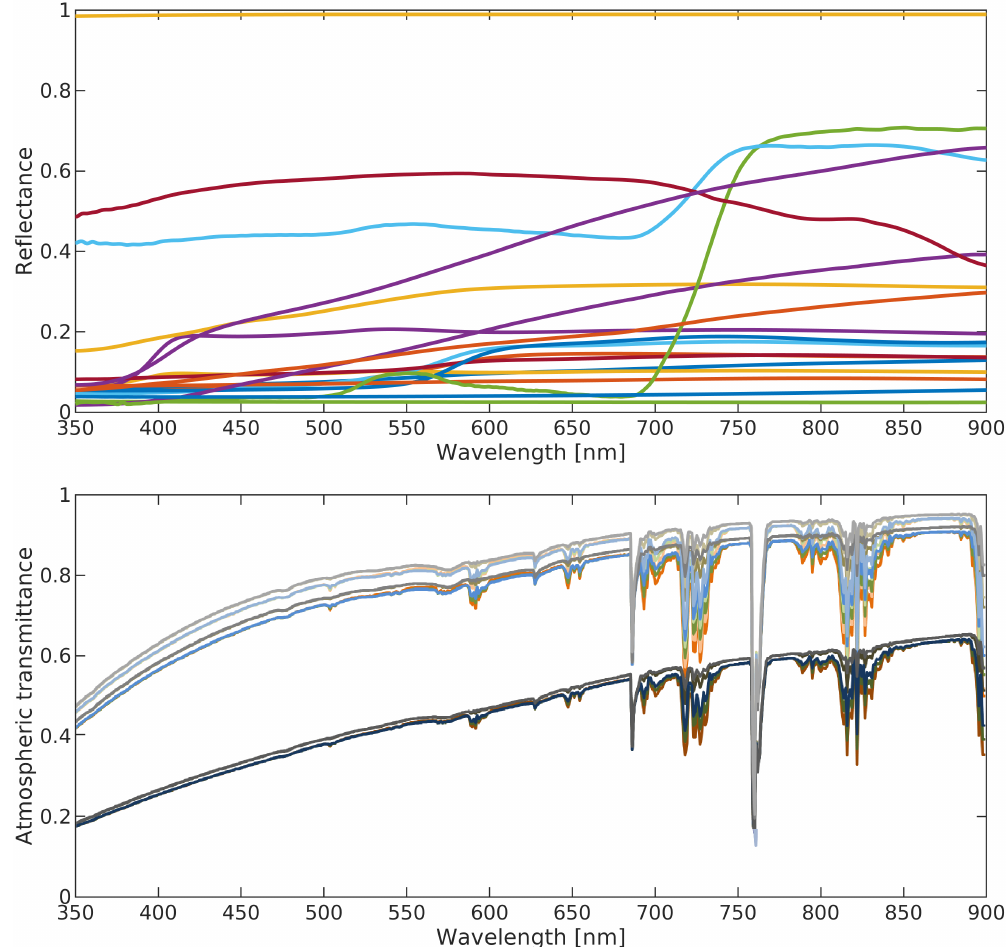
Figure 3. Top : Variation in surface reflectances for selected 18 spectra; bottom : Variation in atmospheric transmission curves for selected five atmospheric profiles and visibilities 10km (minimum; dark lines), 55km (mean), and 100km (maximum; bright